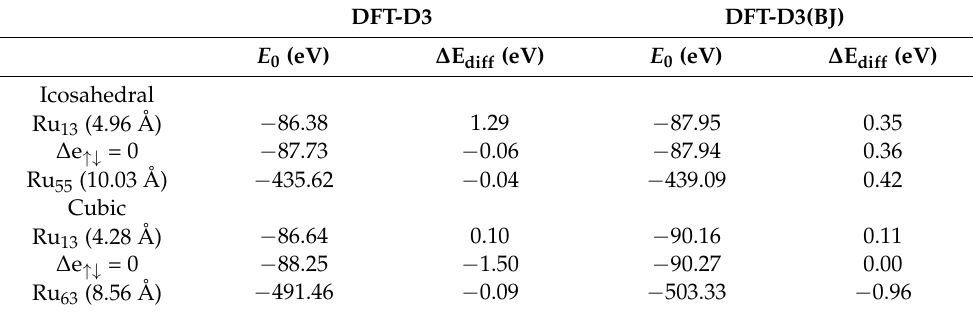
Table 3. Total energy ( E 0 ) and energy difference ( ∆ E diff ) for the fcc Ru icosahedral and cubic nano-dots of two sizes with two modelling methods to include the non-spin-polarised contribution and initial electron orientation distribution ( ∆ e ↑↓ ) configurations for both DFT-D3 and